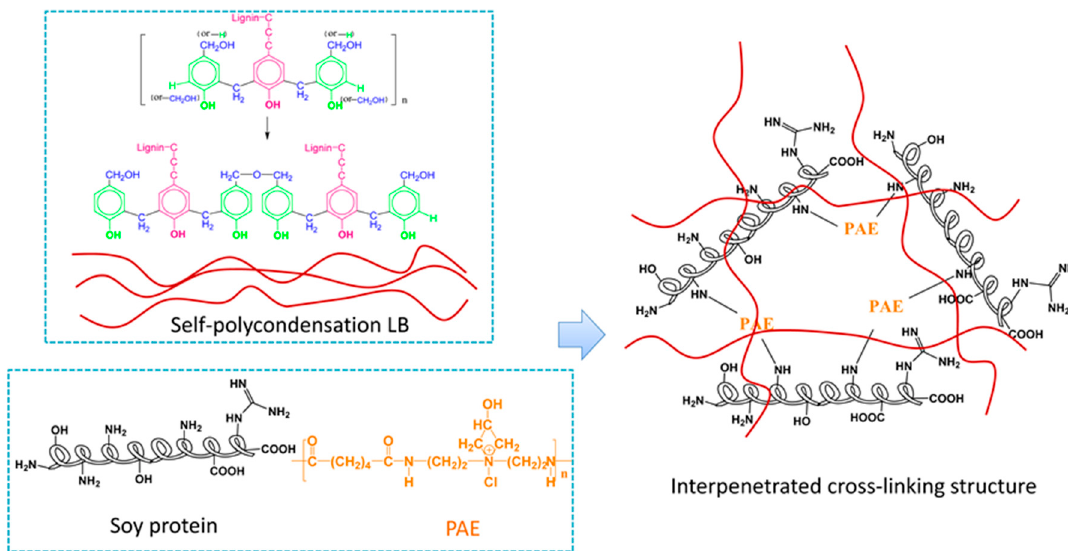
Scheme 2. The formation of the interpenetrated network.